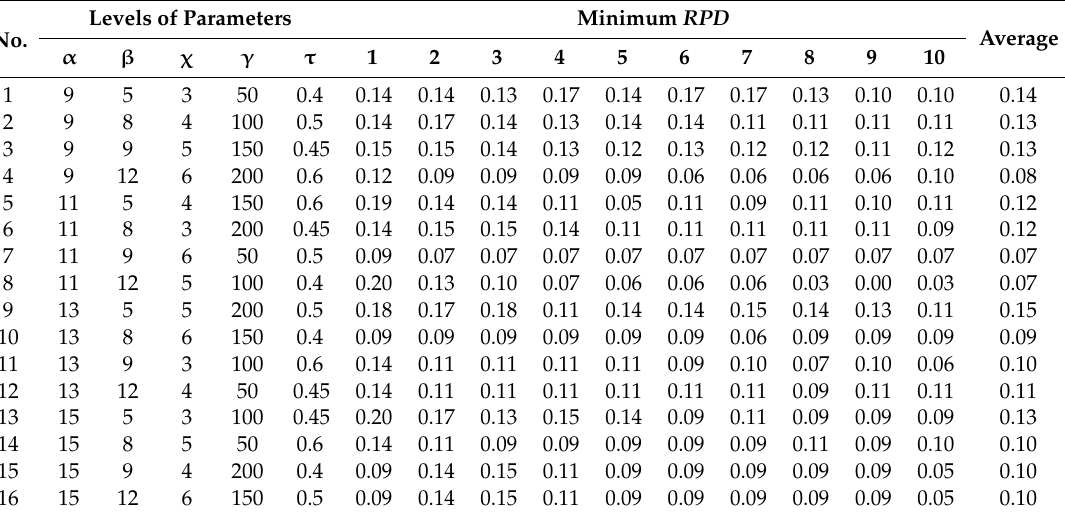
Table 7. The ANOVA results for the parameters.